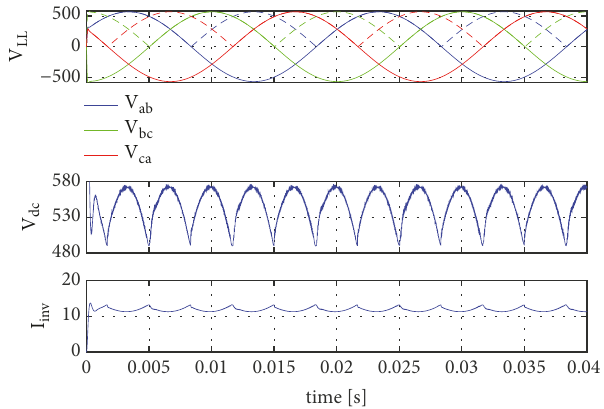
Figure 7: Obtained simulation results of the dc bus voltage 𝑉 𝑑𝑐 and inverter dc bus current I . inv